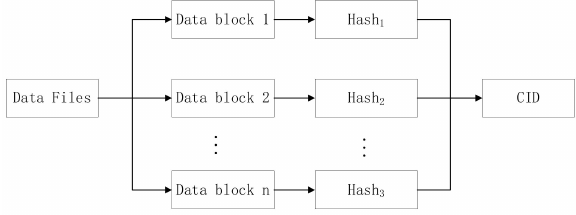
Figure 2. IPFS privacy information storage process.